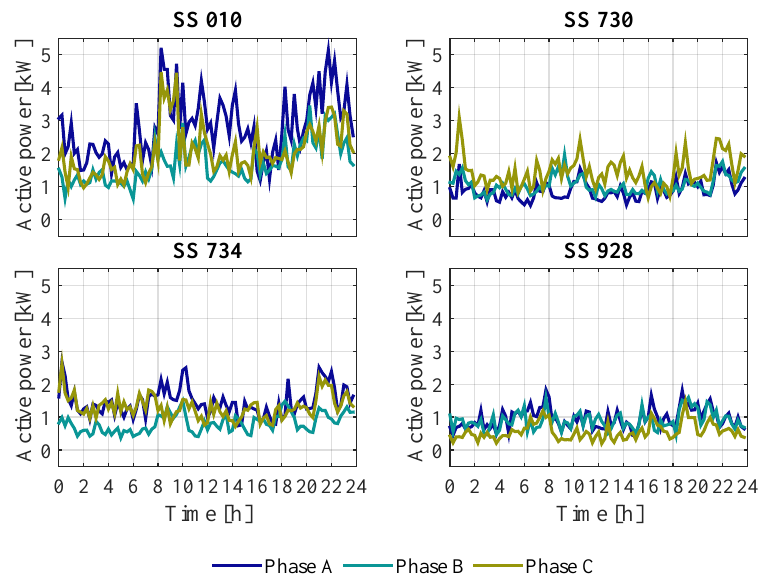
Figure 8. Active power demand profile for phases A, B and C at each Secondary Substation (SS) for scenarios (1) and (2). Note that both scenarios share the same active power demand profile, so results can be applied to both scenarios.